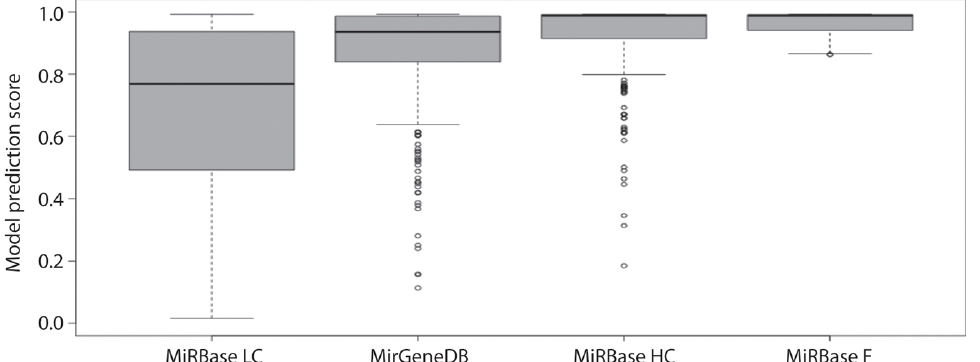
Figure 5: Performance of 259 mirbase hairpins exactly matching MirGeneDB entries (left): Minimum: 0.113, Lower whisker: 0.804, Lower quartile: 0.907, Median: 0.977, Upper quartile: 0.988, Upper whisker: 0.992, Maximum: 0.993; and rest of miRBase (right): Minimum: 0.012, Lower whisker: 0.596, Lower quartile: 0.833, Median: 0.979, Upper quartile: 0.990, Upper whisker: 0.993, Maximum: